Question: What type of chart is this?
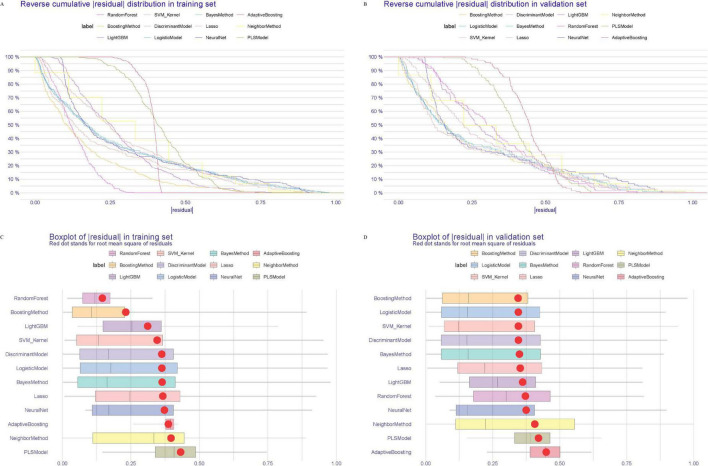
Answer: box